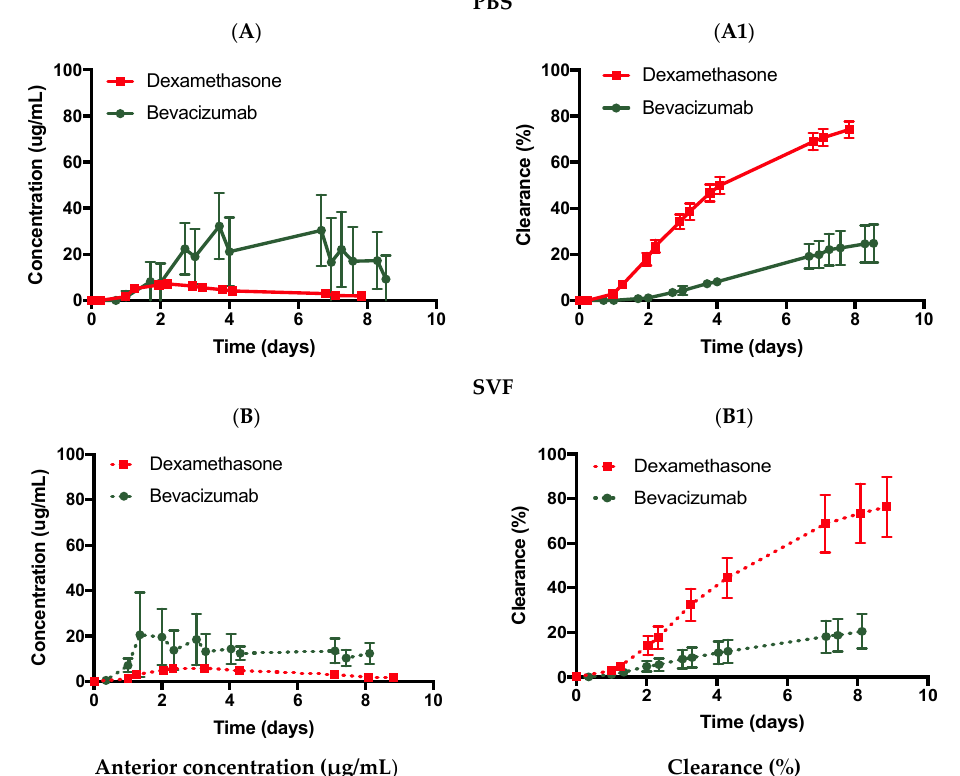
Figure 5. Effect of diffusion using the ciliary flow inlet model with bevacizumab (1.25 mg, 50 µL) and dexamethasone (0.1 mg, 100 µL) injected in ( A , A1 , solid line ) PBS, pH 7.4 and ( B , B1 , dashed line ) SVF. All data are presented as the mean (n = 5) and standard deviation (±STD).